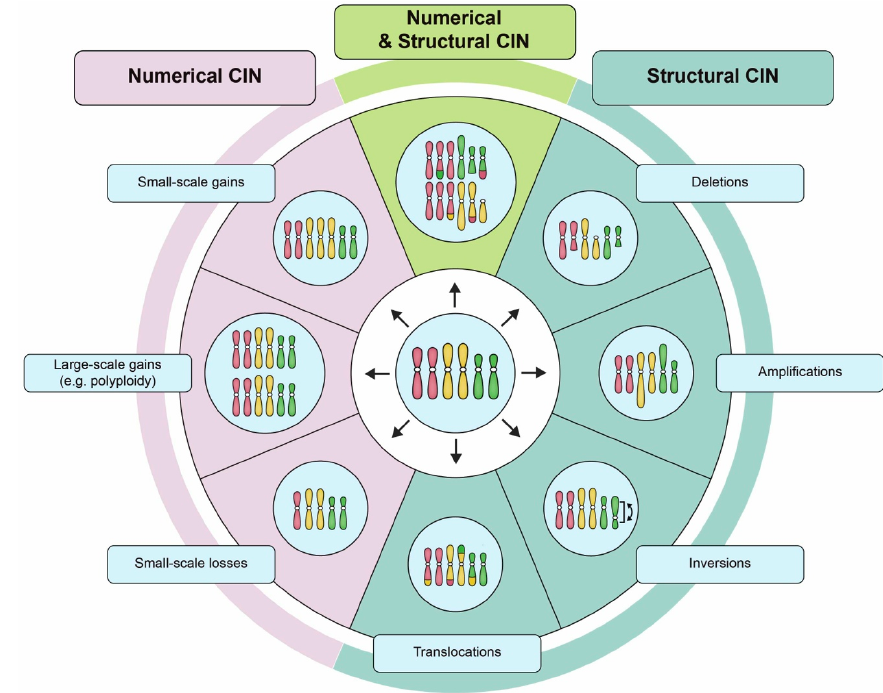
Figure 1. Examples of numerical chromosome instability (CIN) and structural CIN. A schematic depicting examples of the types of karyotypic changes associated with either numerical CIN (N-CIN) or structural CIN (S-CIN). Note that to accurately define CIN within a given population requires